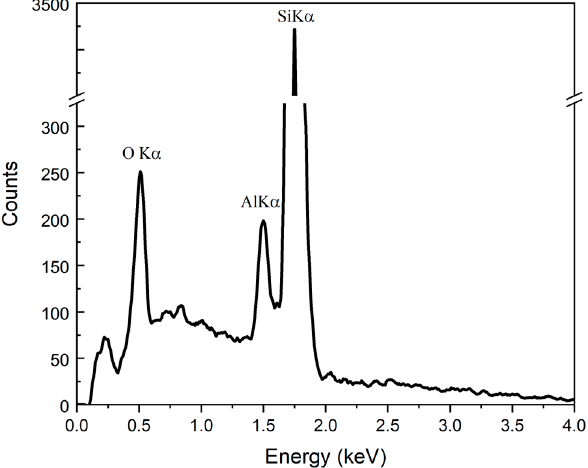
Figure 5. EDS elementary analysis of PEALD Al 2 O 3 ultra-thin fi lm at 250 °C.